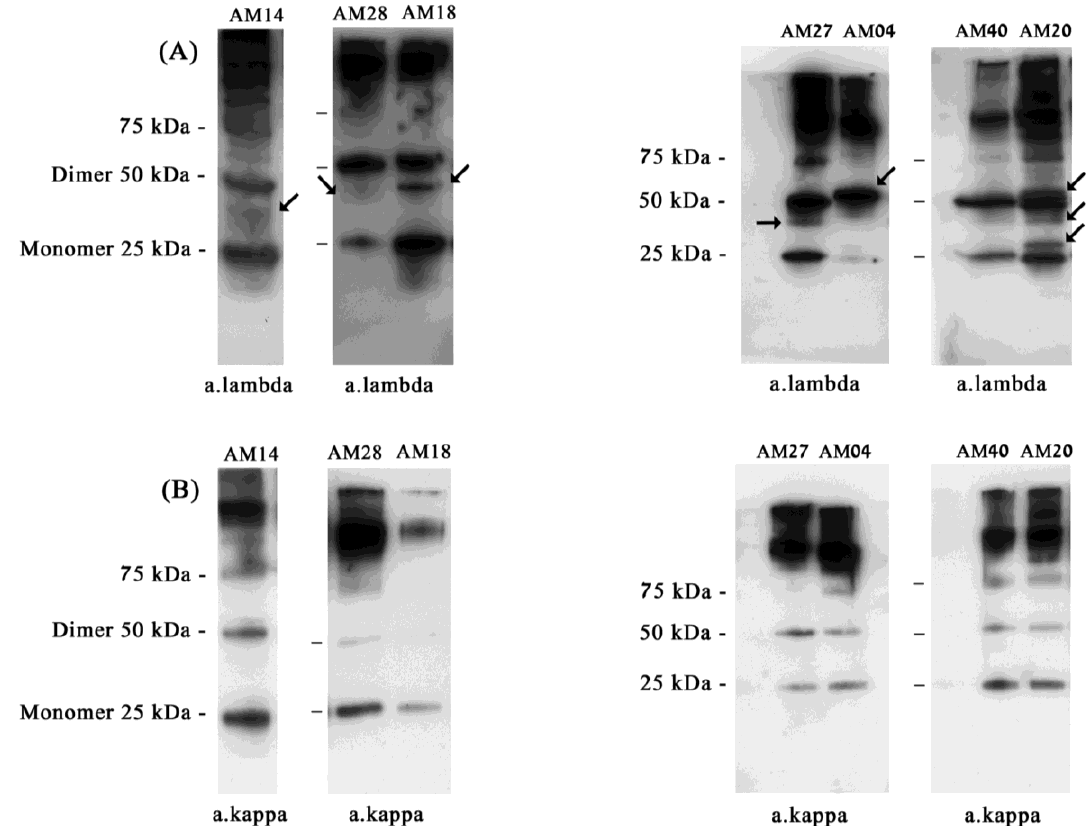
FIGURE 3 . Western blot analysis of FLCs in the plasma of  patients with AL-  amyloidosis. Plasma samples from patients AM20, AM14, AM28, and AM18 were run on 10–20% Nu-Sep gels under nonreducing conditions and immunostained using anti-  (A) and anti-  (B) antibodies. The abnormally migrating monoclonal FLC species are indicated by arrows. Reproduced from Kaplan et